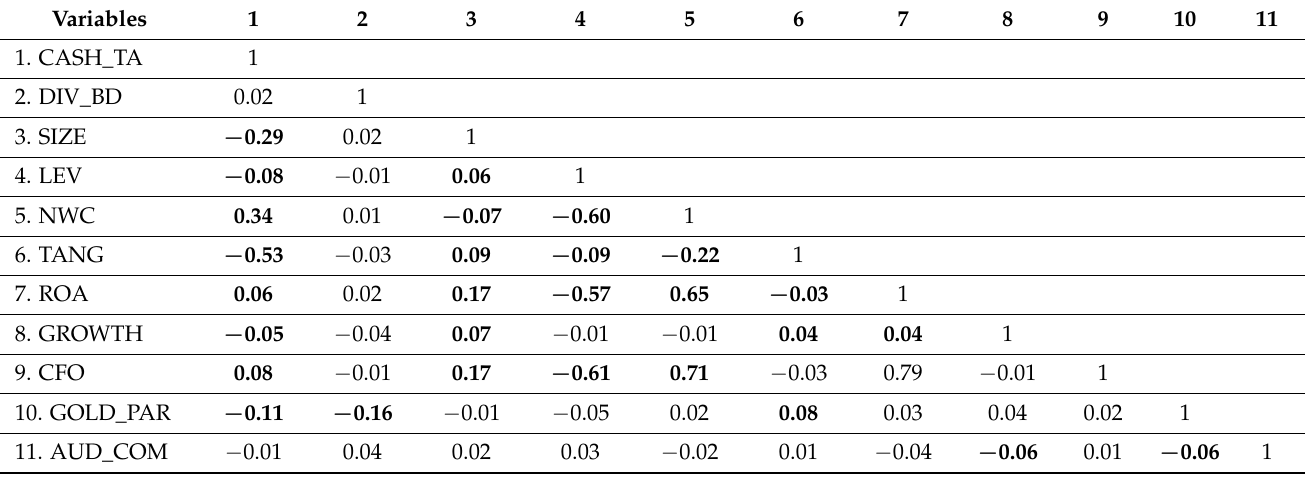
Table 3. Pearson correlation coefficients of the sample